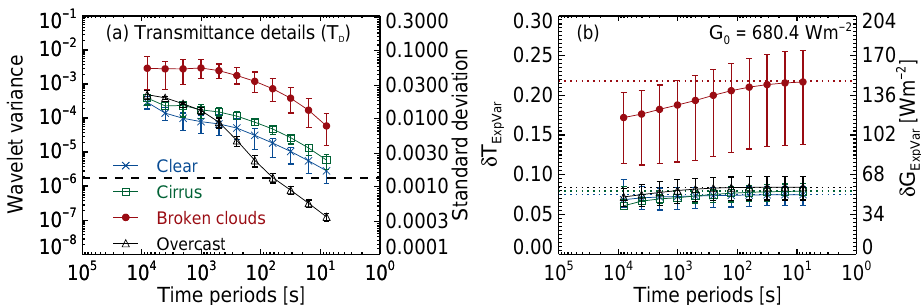
Figure 4. (a) Wavelet variance, and the (b) cumulative variance (from Eq. 1) of global transmittance from all the pyranometer stations in the observation domain as a function of considered frequency/averaging period for cases during the HOPE campaign. As the time period is inversely proportional to the frequency, the time periods (on x axis) are represented in ascending order of frequency scales. The vertical bars around the mean value represent the observed minimum and maximum variances. The dashed horizontal line in (a) corresponds to the measurement uncertainty of our pyranometer. The dashed horizontal lines in (b) denote the total variance of the original time series averaged across all stations within the observation domain.